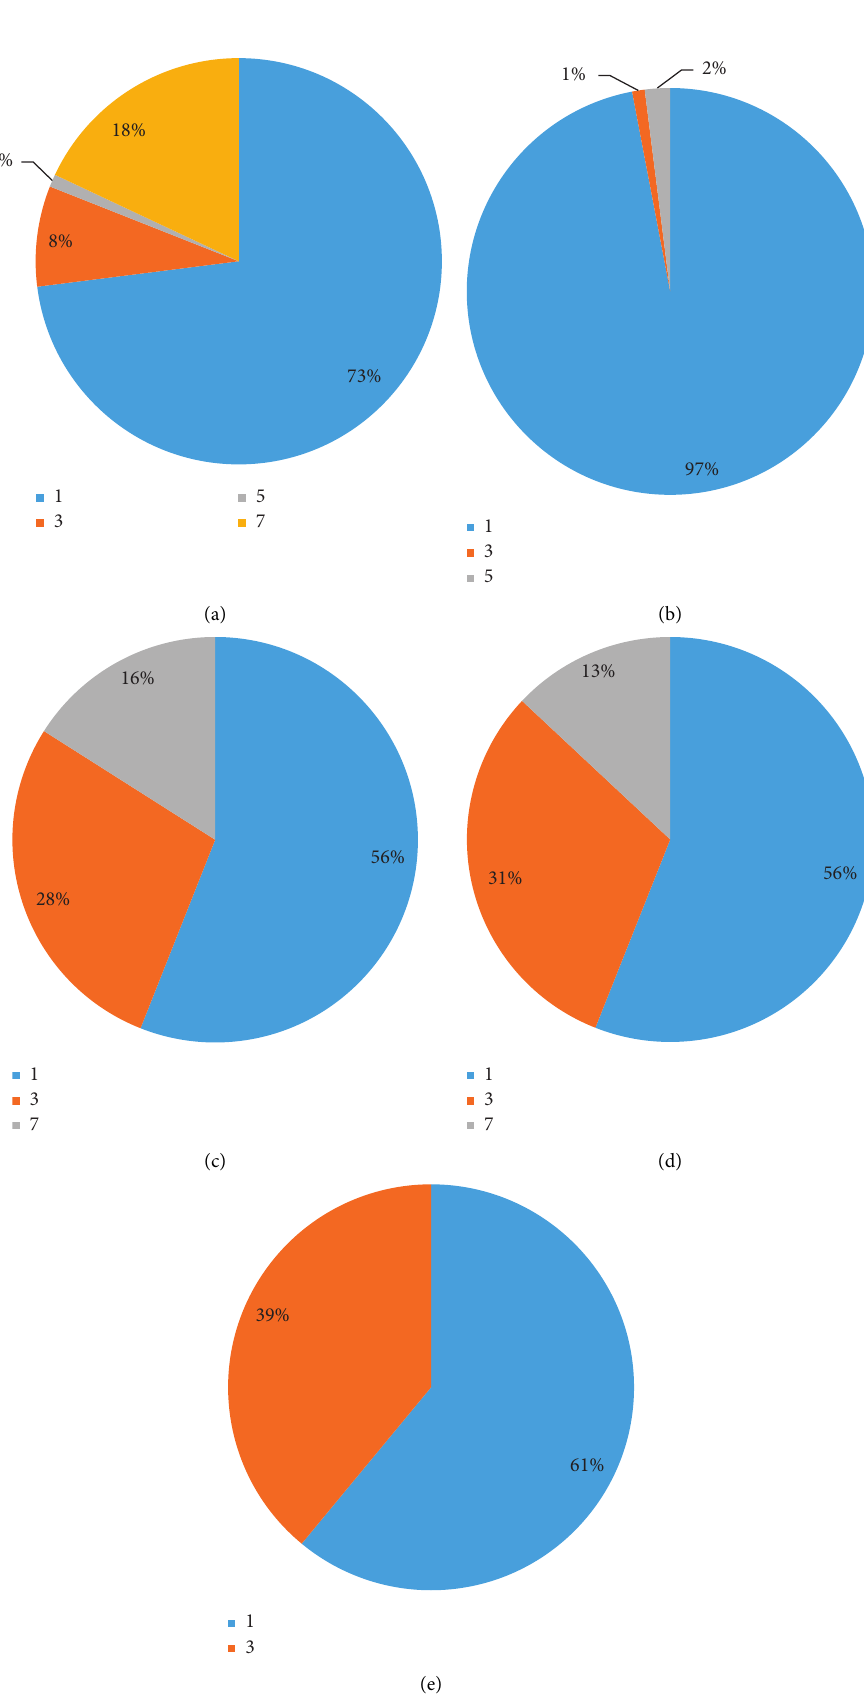
Figure 9: Visualization of prediction